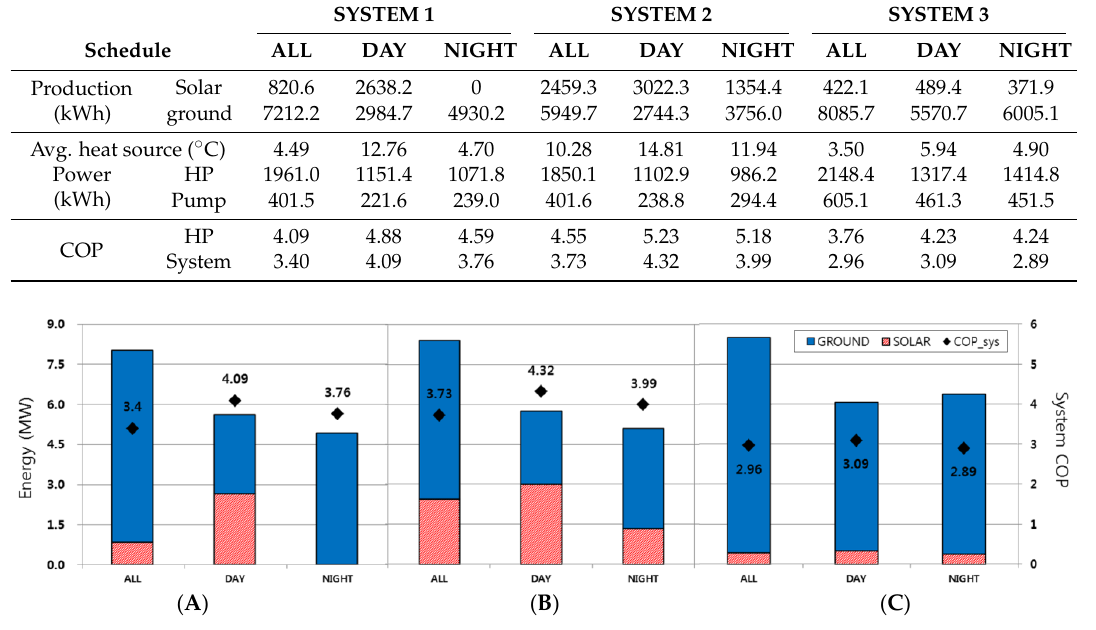
Figure 5. Energy production and system COP in case. ( A ) SYSTEM 1; ( B ) SYSTEM 2; ( C ) SYSTEM 3.